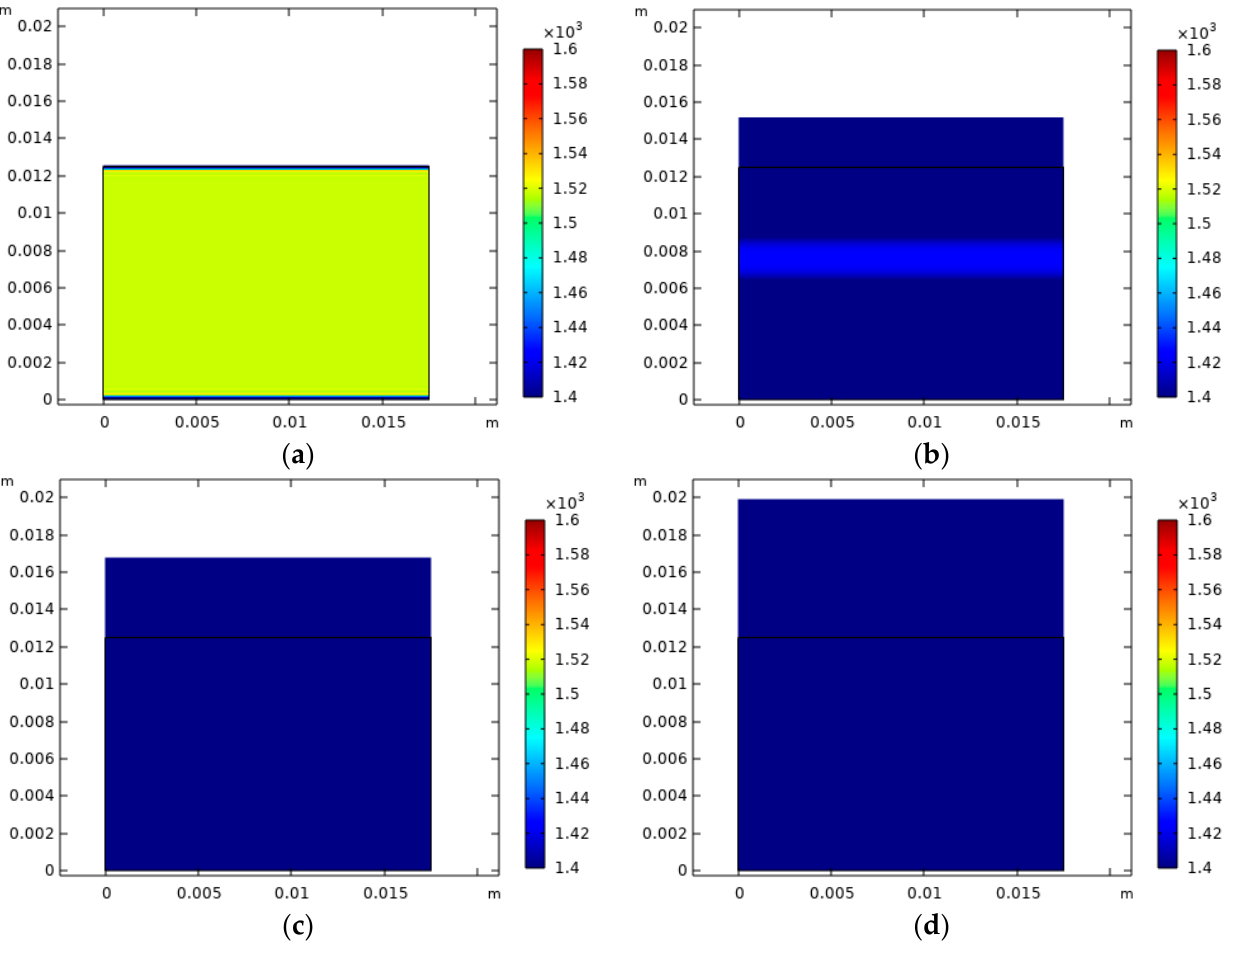
450 min) (under 21 kPa vertical stress (free swelling), Path ABCD, hydration stage AB).